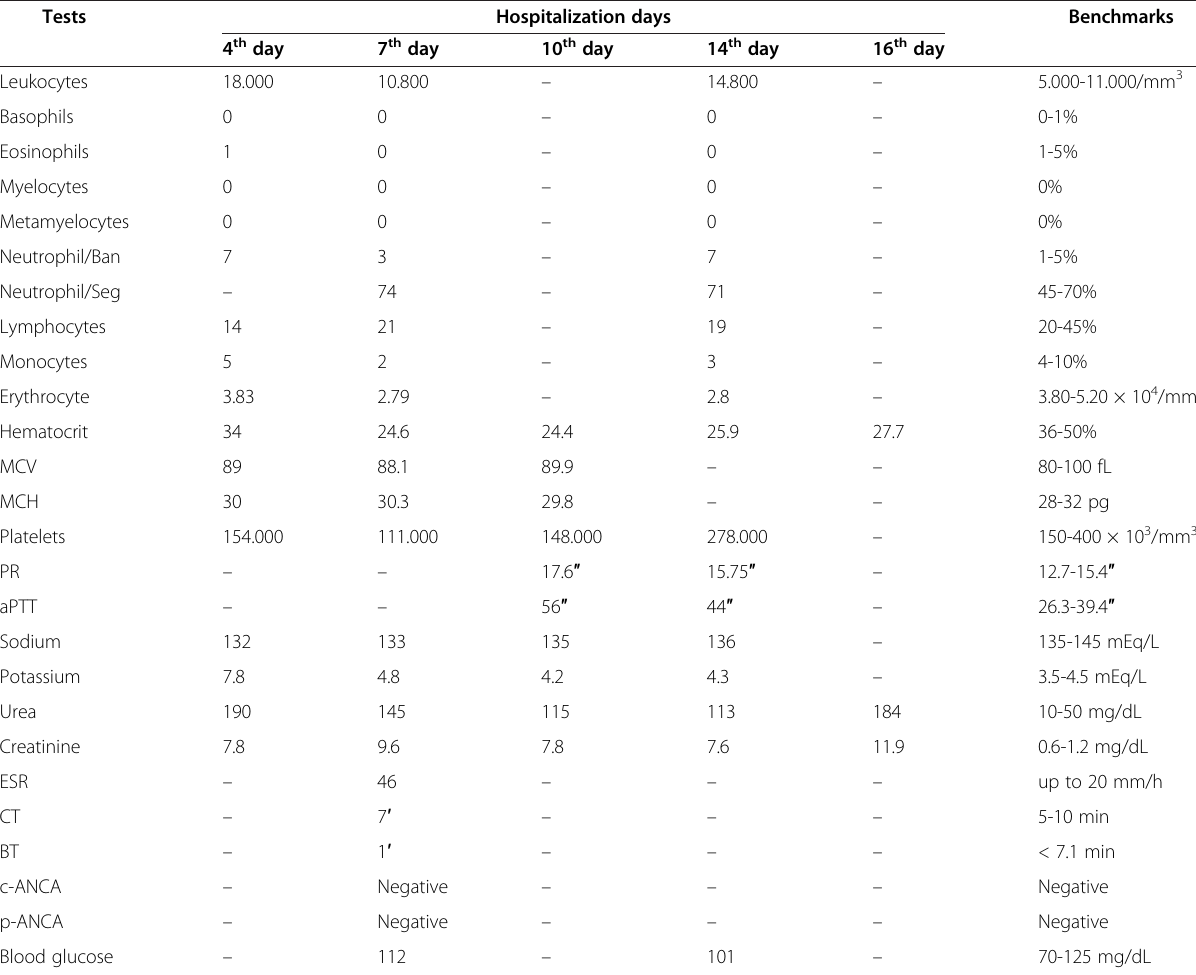
Table 1 Report of laboratory tests